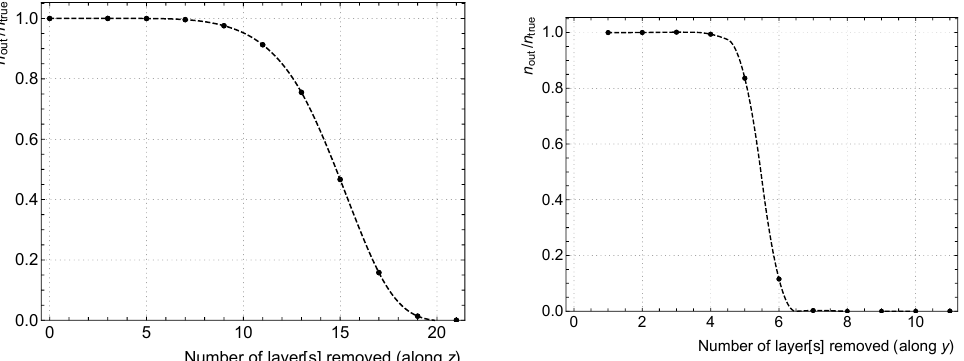
Figure 6. Normalized N predictions of test sets for which z (backside forwards) or y (outside inwards) layers have been